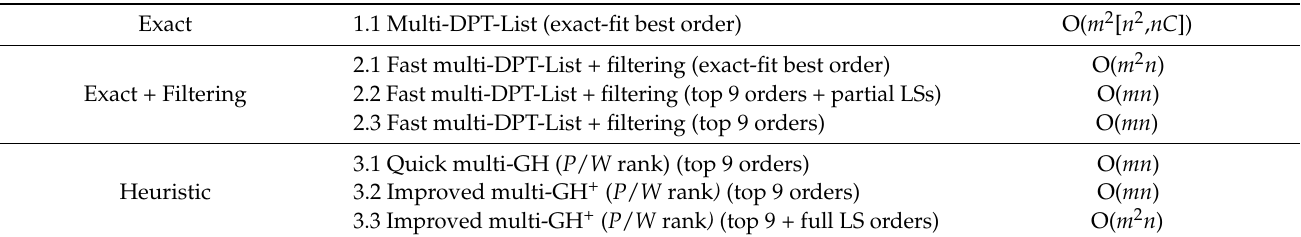
Table 5. Results (total profits) of datasets with capacities C ± 10 ( m = 2). m =